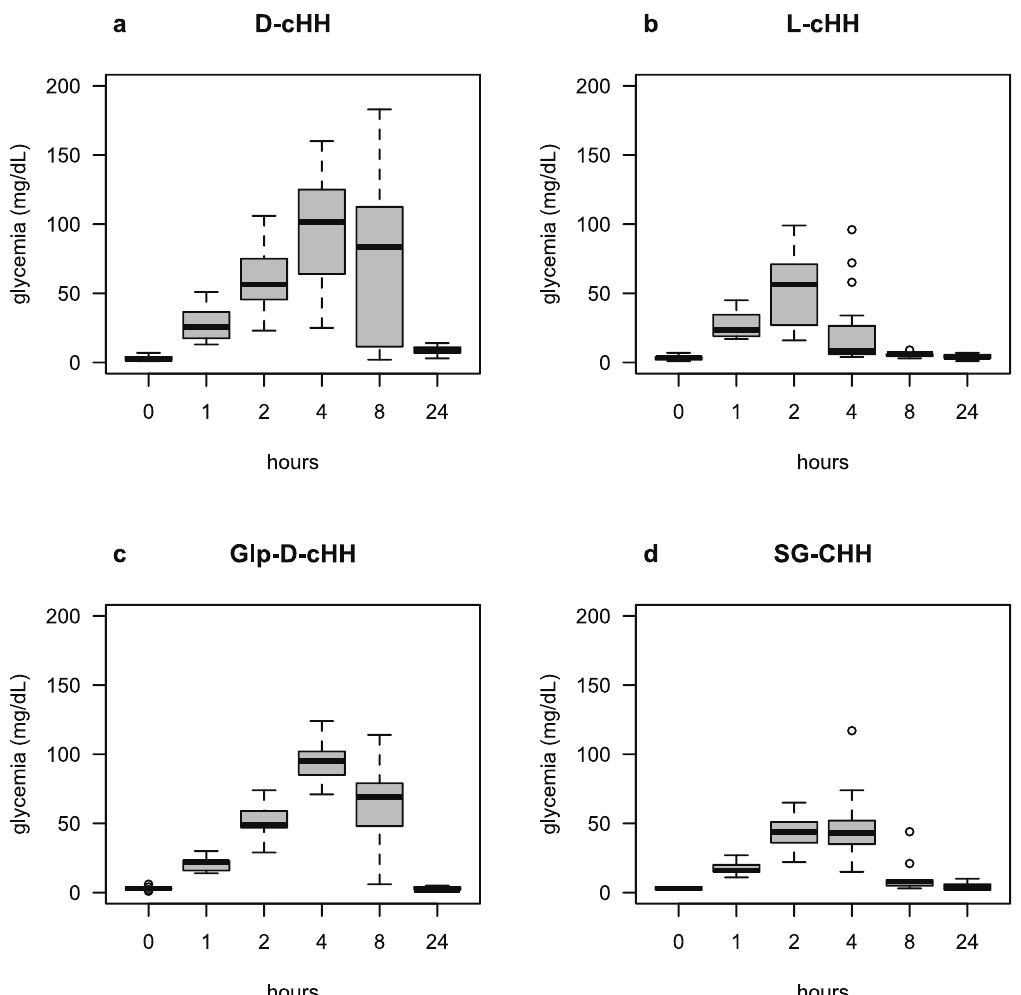
Figure 3. Time course of the induced glycemia after injection of the synthetic and wild type cHHs. a) Time course of hemolymph glycemia after injection of 1.7 pmol/g live weight of D-cHH. The maximum peak of 95.4 6 8.1 mg/dL glucose is reached after 4 h, high values lasting at 8 h (76 6 12.1 mg/dL), when the maximum values were also recorded, and the glycemia returning to its nearby basal level, 8.9 6 1 mg/dL, after 24 h. N=20. b) Time course of hemolymph glycemia after injection of 1.7 pmol/g live weight of L-cHH. L-cHH induced a slower hyperglycemic response with the maximum peak of 52 6 6.5 mg/dL glucose after 2 h, and the glycemia returning to its nearby basal level, 5.5 6 0.4 mg/dL, after 8 h. N=16. c) Time course of hemolymph glycemia after injection of 1.7 pmol/g live weight of Glp-D-cHH. The time course of Glp-D-cHH shows the stronger hyperglycemic response of 96.1 6 5.6 mg/dL glucose after 4 h, high values lasting at 8 h (62.9 6 11.8 mg/dL) and the glycemia returning to its basal level, 2.9 6 0.5 mg/dL, after 24 h. N=9. d) Time course of hemolymph glycemia after injection of 1.7 pmol/g live weight of SG-cHH. The hyperglycemic time course after the injection of 1.7 pmol/g live weight of purified SG-cHH was comparable to that of synthetic D-cHH and Glp-D- cHH peptides, but the maximum (44 6 4.5 mg/dL) was reached after 2 h and the glycemia returning to its basal level, 5 6 1.1 mg/dL after 24 h.